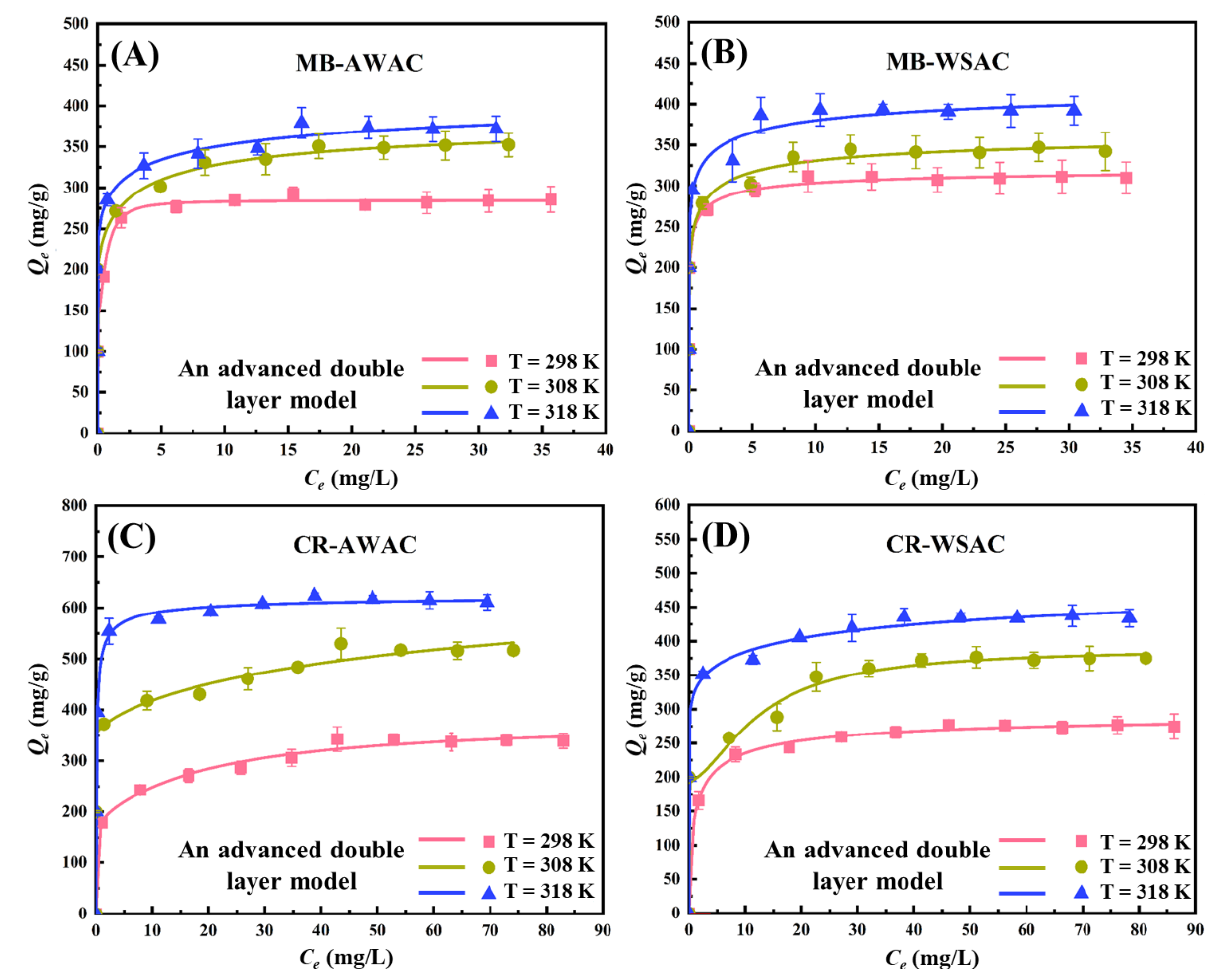
Figure 1. Experimental adsorption isotherms for four adsorption systems (MB-AWAC ( A ), MB- WSAC ( B ), CR-AWAC ( C ) and CR-WSAC ( D ))at 298~318 K, pH = 7, and corresponding fitting curves by using an advanced statistical physics adsorption model (double-layer model with two energies).